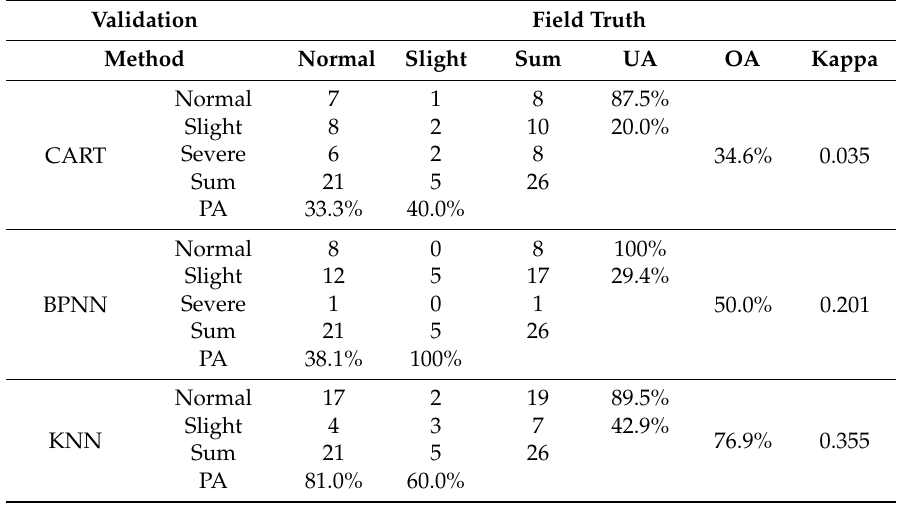
Table 8. Validation of the traditional single-date VIs-based models using field truth samples in region